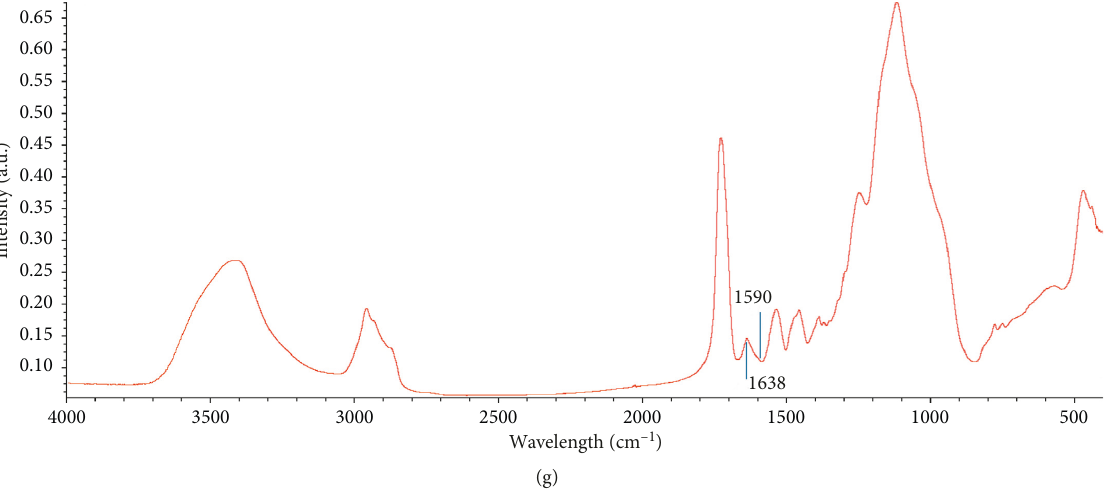
Figure 3: Representative FTIR spectra of all tested groups. (a) Unpolymerized resin cement; (b) A1 tested group; (c) A2 tested group; (d) B1 tested group; (e) B2 tested group; (f) C1 tested group; (g) C2 tested group. Table 4: Two-way ANOVA for the VH values.